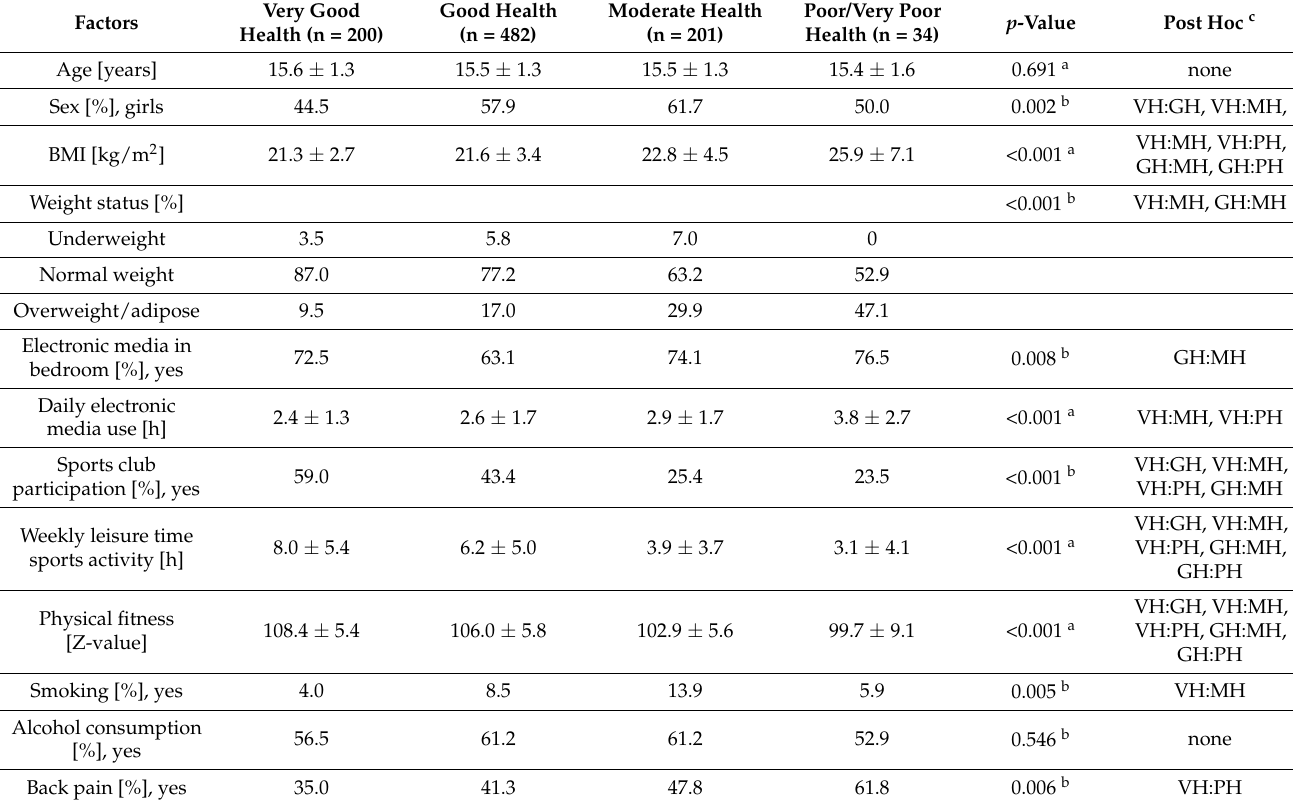
Table 1. Group differences in factors between adolescents with a very good, good, moderate, and poor/very poor perceived health. Values are means with SD or prevalence